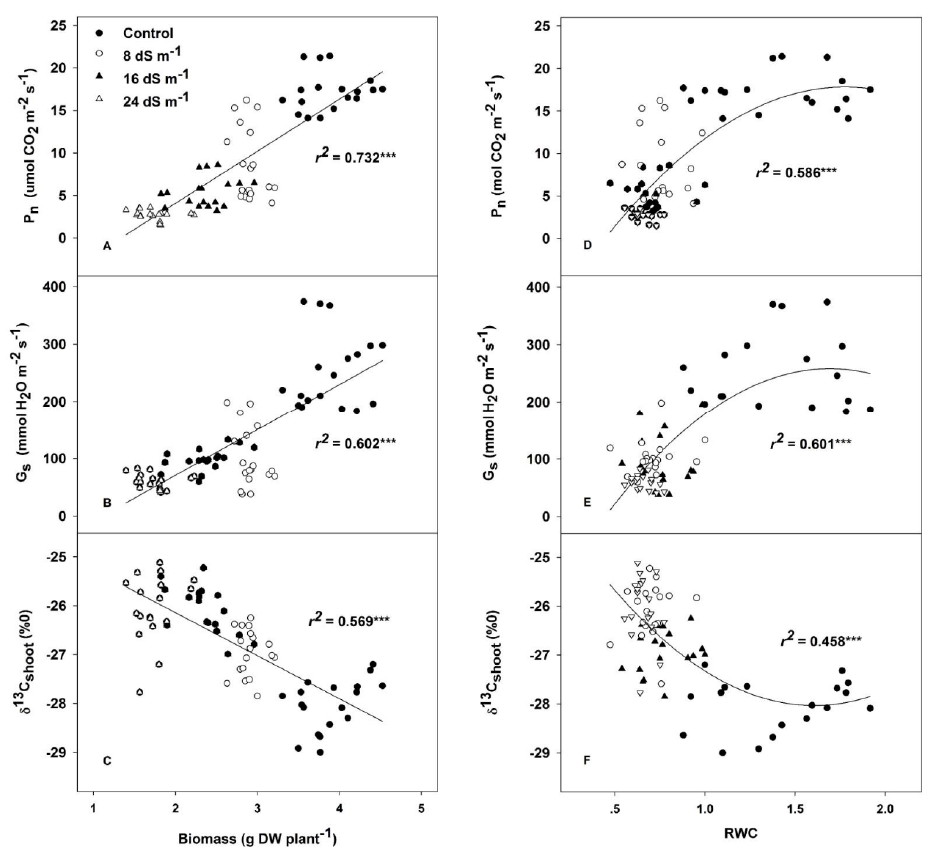
Figure 2. The relationship of shoot biomass to leaf net photosynthetic rate (P n ) ( A ); stomatal conductance (g s ) ( B ); and stable carbon isotopes ( δ 13 C shoot ) ( C ). The relationship of relative water content (RWC) to leaf net photosynthetic rate (P n ) ( D ); stomatal conductance (g s ) ( E ); and stable carbon isotopes ( δ 13 C shoot ) ( F ). Each point represents the individual value for a given replicate and genotype within each growing